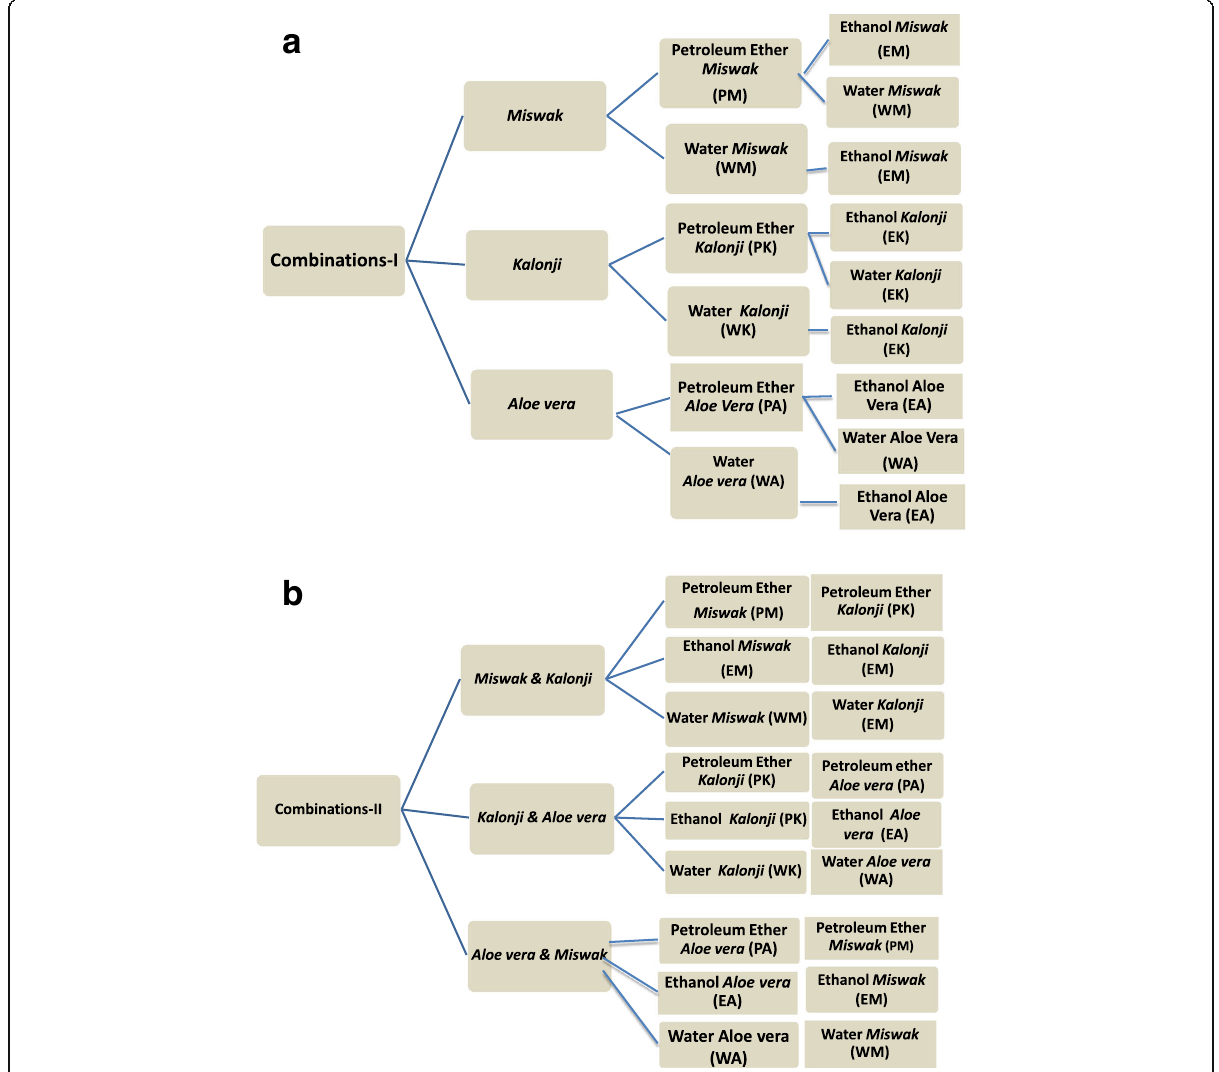
Fig. 1 Preparation of herbal extracts in combinations: a Combination prepared by mixing extracts of same herb extracted in different solvents ( b ) Combination prepared by mixing different herbal extracts in the same